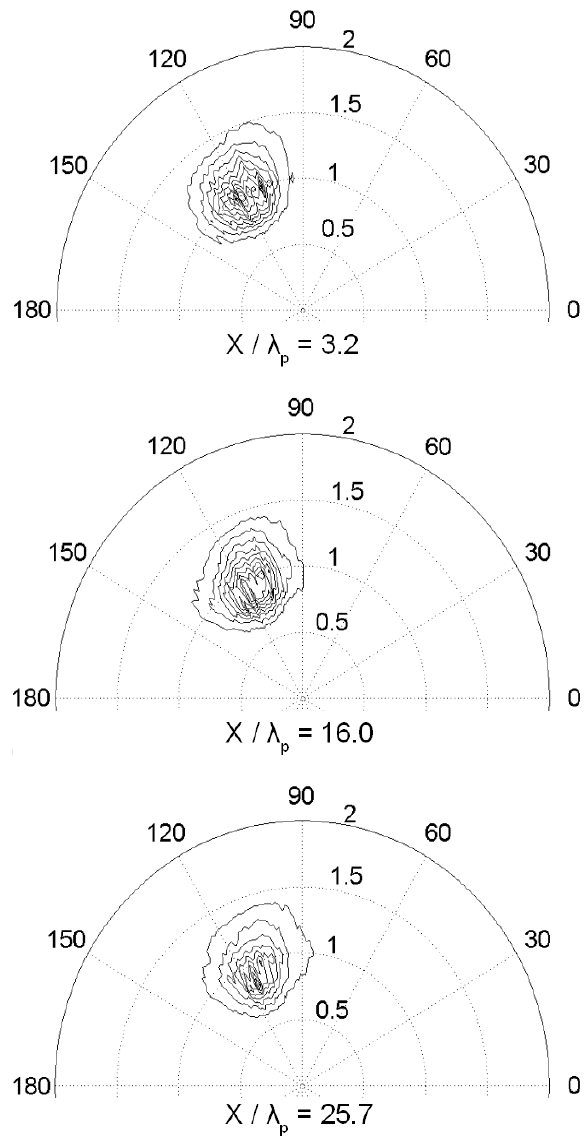
Fig. 3. Reconstructed directional wave spectra at different distances from the wave-maker x / λ p